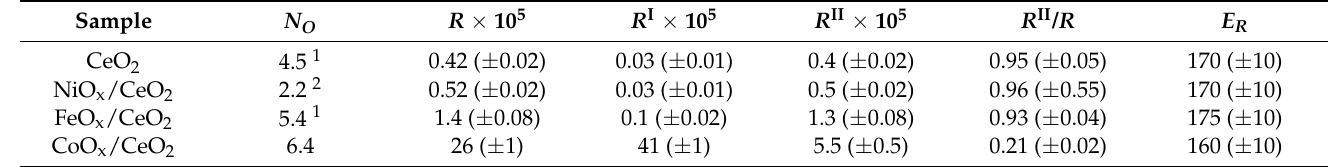
Table 1. Quantities of exchangeable oxygen during TPIE ( N O , 1 × 10 21 at/g), rate values R , R I , R II (mole/m 2 s) for different types of oxygen exchange at reference temperature 750 ◦ C and their activation energies E R (kJ/mole) for different samples.